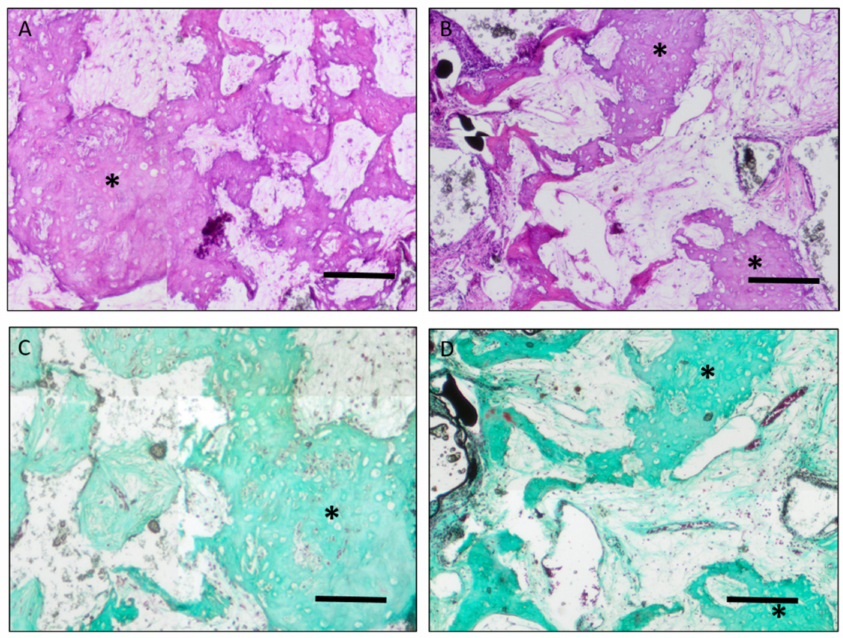
Figure 6. H&E and Masson Goldners’ trichrome staining of bone formations in group C and C irrad (Asterisk: bone formations; ( A , C ): group C; ( B , D ): group C irrad, ( A , B ): H&E staining; ( C , D ): Masson Goldners’ trichrome staining). Scale bar 0.2 mm. Total magnification ×